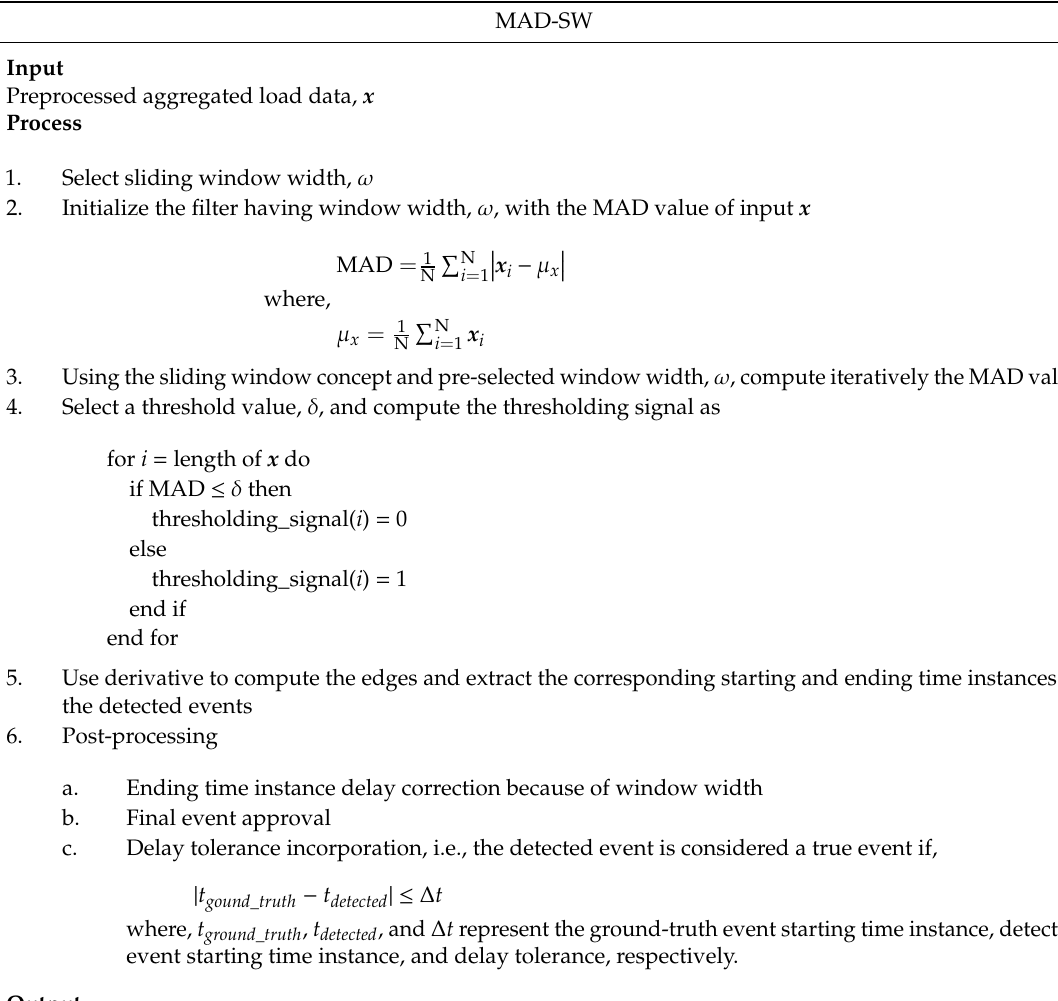
Table 1. Event detection algorithm